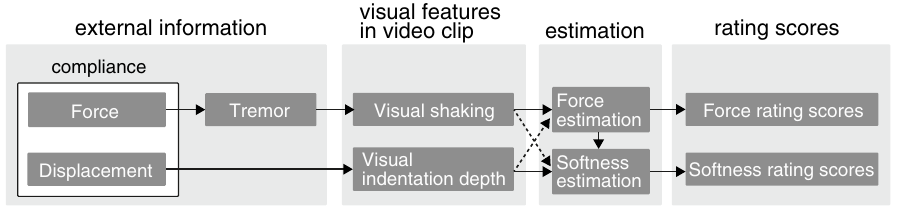
Figure 5. Flow of force and softness estimation from external information via visual features in video clip in our